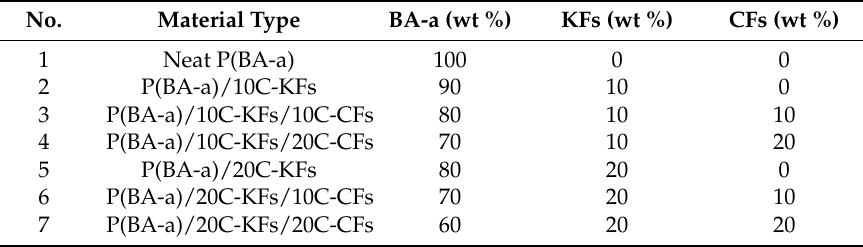
Table 2. Neat and hybrid formulations investigated with different weight